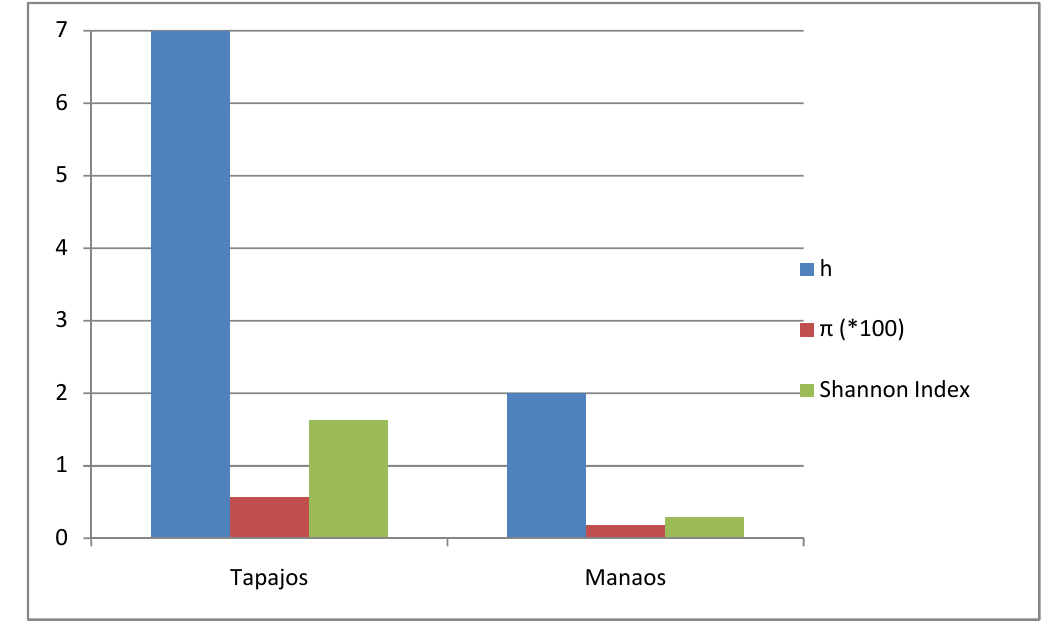
Figure 4. Diversity parameters of fishborne Pseudomonas communities from the Amazonian Tapajòs and Negro tributaries. Metagenetic h and π parameters, and Shannon